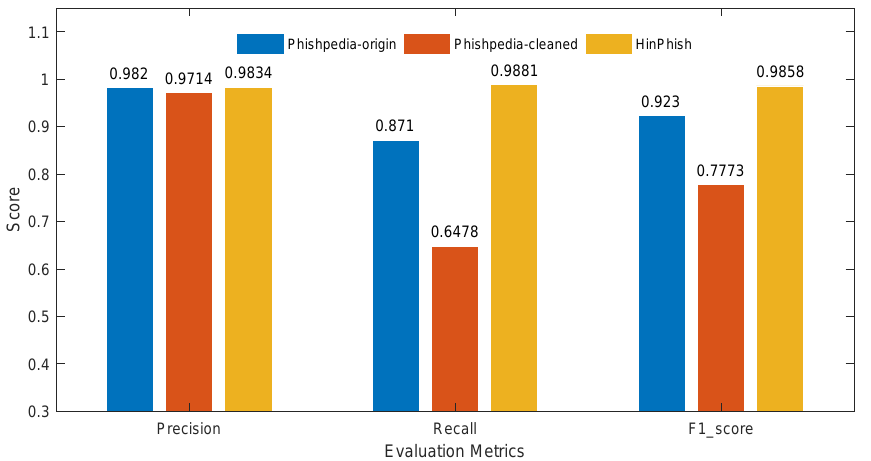
Figure 7. The experimental results with Phishpedia and